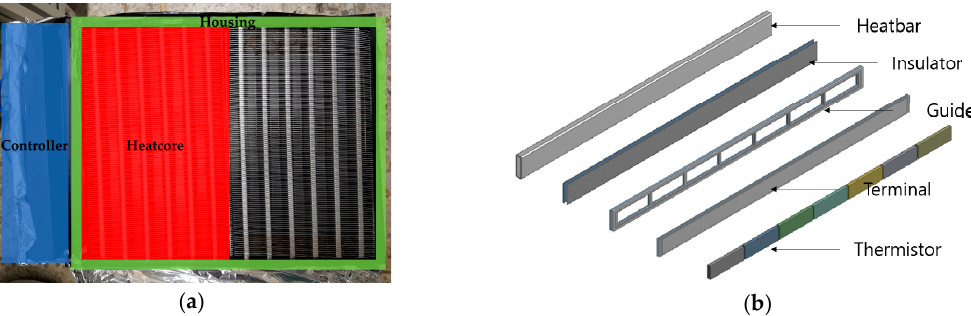
Figure 1. 6 kW class high-voltage positive temperature coefficient (PTC) heater and heat rod design: ( a ) PTC heater design; ( b ) components of heat rod.